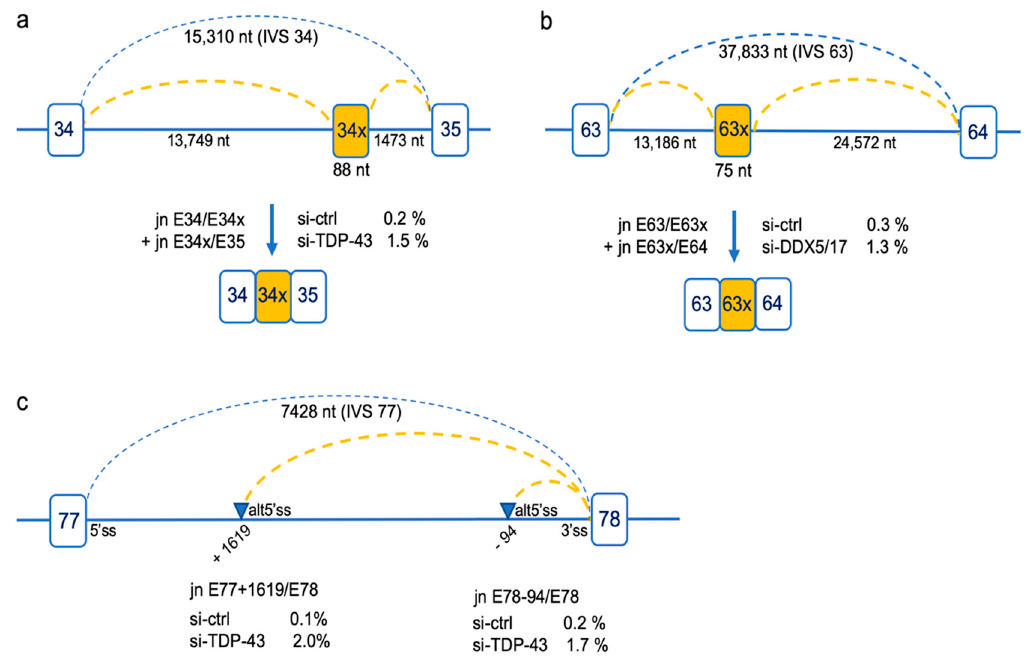
Figure 3. Rare splicing events resulting from the usage of alternative intronic splice sites. When changes in splice junction (SJ) usage in a lower range were considered (0.05 ≥ | ∆ SJ | ≥ 0.01), aberrant junctions resulting from the use of deep intronic splice sites were detected in DDX5/17 and TDP-43 KD conditions resulting from the insertion of pseudoexons originating from intron 34 or intron 63 ( a , b ) or resulting from the use of alternative 5 ′ splice sites (alt5 ′ ss) in intron 77 (blue triangles) ( c ). The SJ values in RBP (si-TDP-43 and si-DDX5/17) and control (si-ctrl) KD conditions are indicated.